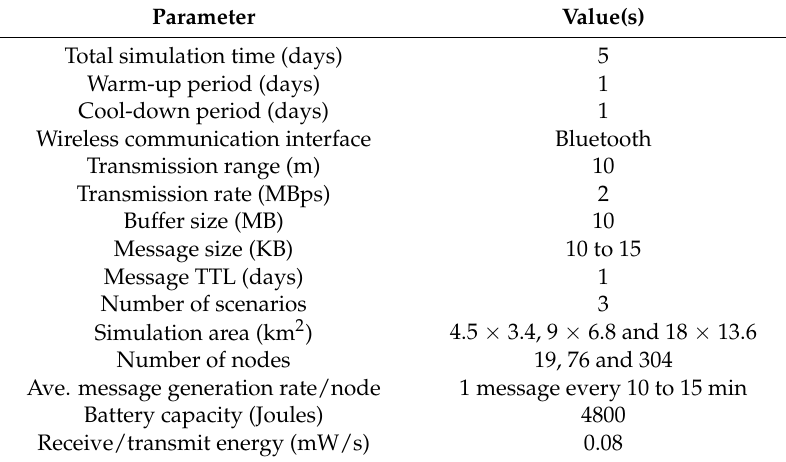
Table 1. Simulation parameters for the small, medium and large scenarios.